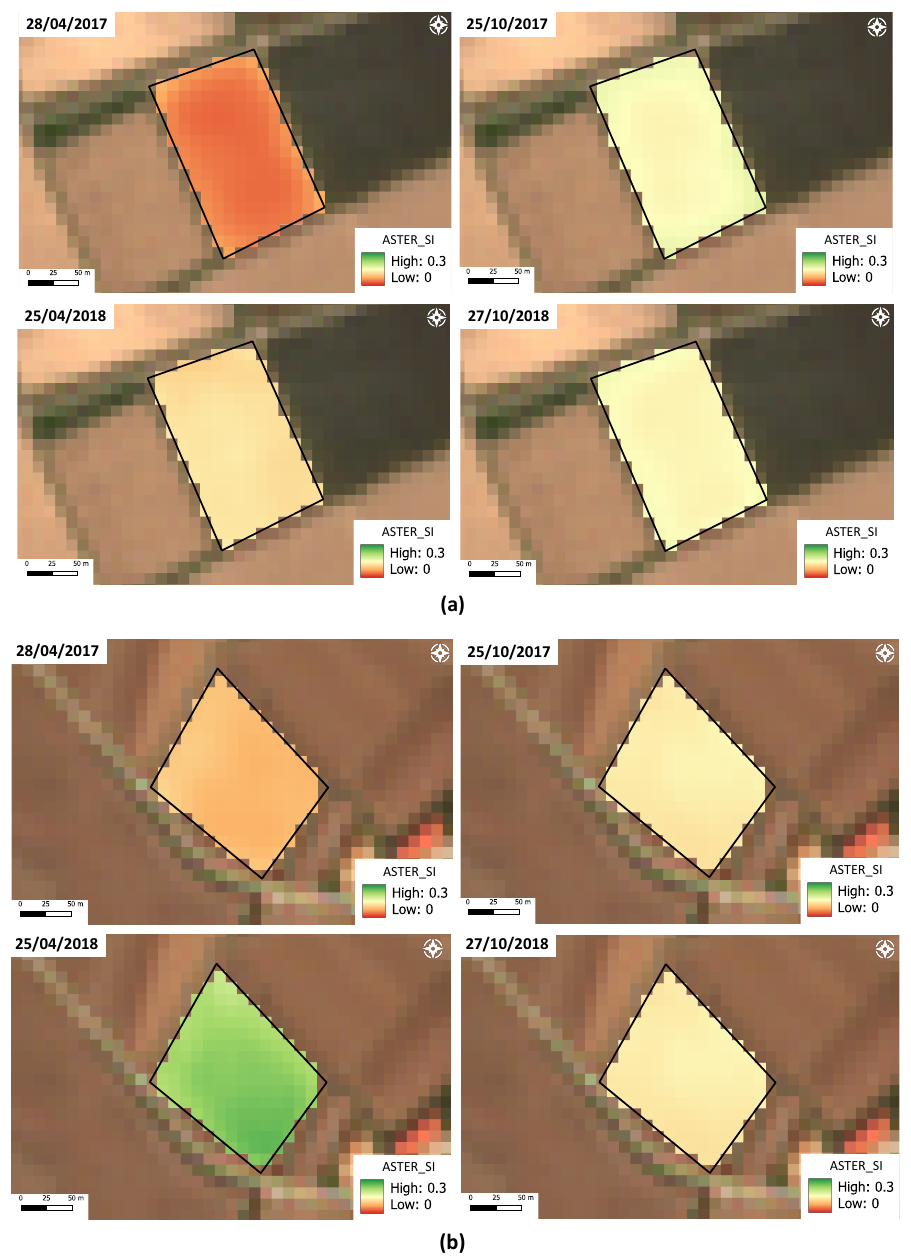
Figure 5. Spatial distribution of ASTER_SI in the selected field plots: ( a ) Quinta do Canal and ( b ) Pranto. The samples are from the Spring and Autumn of 2017 (top panels) and 2018 (bottom panels), before and after the rice crop cultivation period.